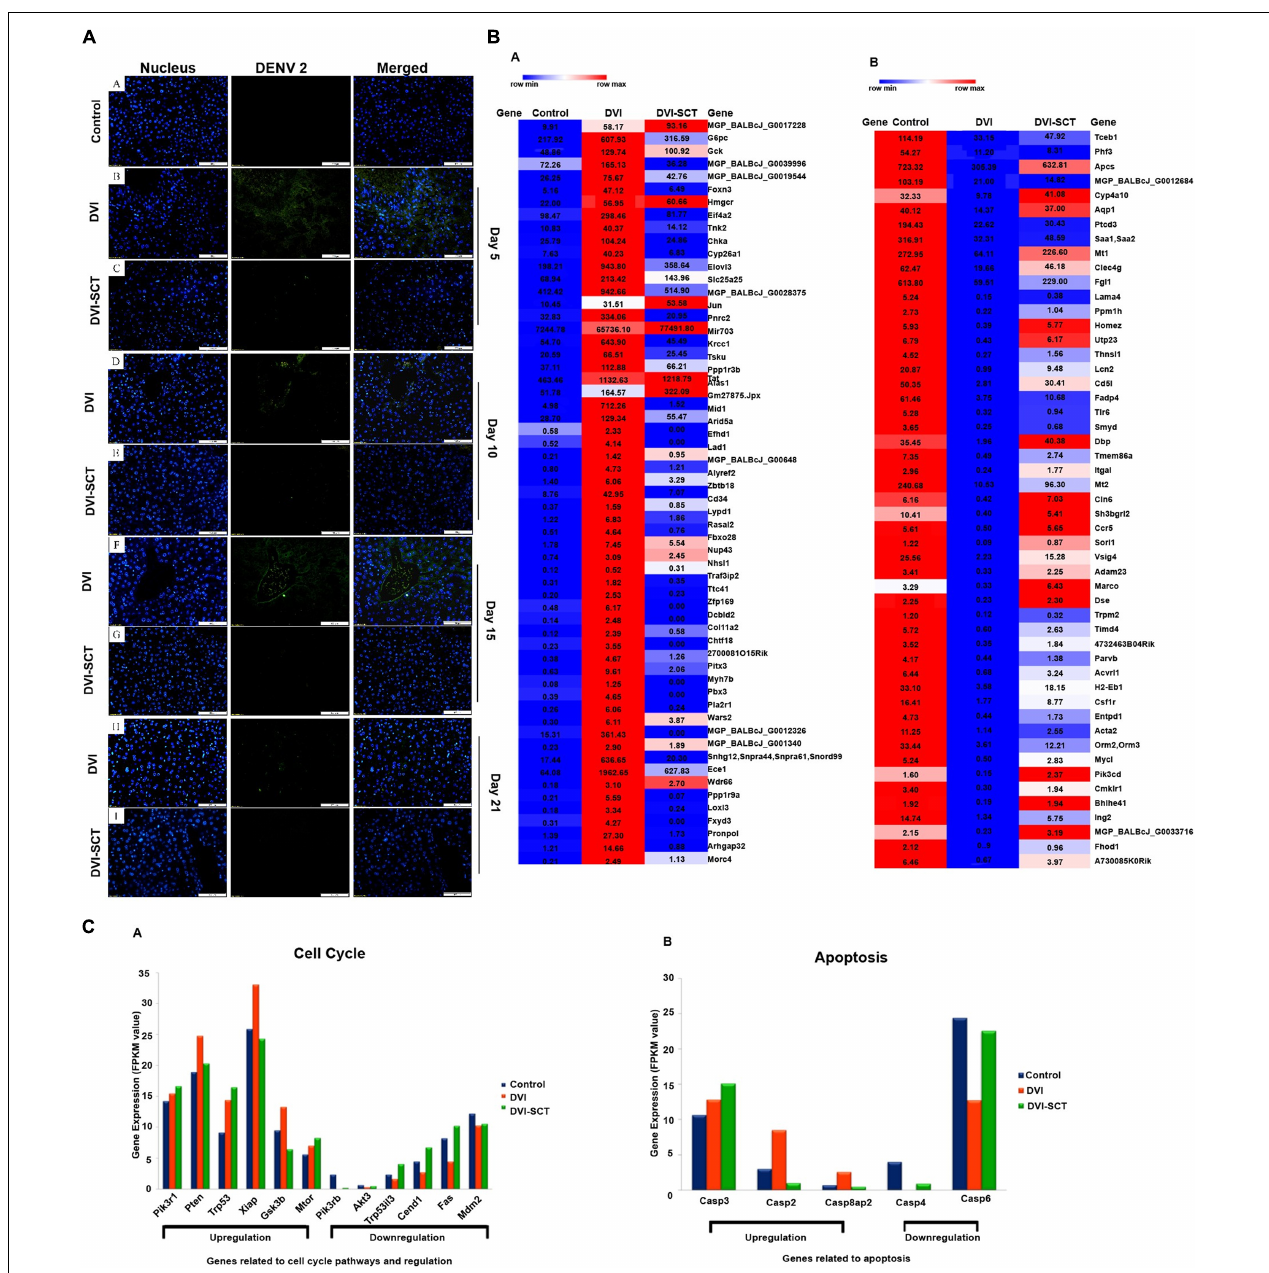
FIGURE 3 | Immunohistochemical assessment and next-generation sequencing. (A) Immunohistochemical study of DENV-infected BALB/c mice liver at different dpi. Liver sections were captured at a magnification of × 200 under a fluorescence microscope. (a) Control group, (b,c) liver sections of DENV-infected and stem-cells-treated mice on the 5th dpi, (d,e) 10th dpi, (f,g) 15th dpi, and (h,i) 21st dpi. Blue (DAPI-stained nuclei) and green (Alexa Fluor stained DENV antigen). The green fluorescence seen in the DVI group was diminished in the DVI-SCT group. (B) Heatmap of upregulated genes. (C) Heatmap of downregulated genes. The dysregulation (up - or downregulation) of liver genes was quantified in three sets of BALB/c mice: control mice injected with Eagle’s minimum essential medium (EMEM) and phosphate-buffered saline (PBS); DVI mice infected with DENV2; and DVI-SCT mice infected with DENV2 and treated with HSCs, EPCs, and growth factor ( n = 3). The heat maps generated were quantified based on the row minimum and row maximum values (specific for each gene), with red indicating genes highly upregulated and blue depicting genes downregulated. (a) Gene expression related to cell cycle pathways and regulation. The genes Pik3r1 , Pten , Trp53 , Xiap , Gsk3b , and Mtor showed gene expression upregulation following dengue virus infection (DVI), which were either corrected to reflect the control levels ( Pten , Xiap , and Gsk3b ) or continuously upregulated to benefit mice ( Pik3r1 , Trp53 , and Mtor ) upon stem cell treatment (DVI-SCT). Meanwhile, the genes Pik3r6 , Akt3 , Trp53i13 , Ccnd1 , Fas , and Mdm2 showed downregulation upon dengue virus infection (DVI), which was also all corrected to reflect control values upon stem cell treatment (DVI-SCT). (b) Upregulated and downregulated genes related to apoptosis. The genes Casp3 , Casp2 , and Casp8ap2 showed upregulated gene expression following dengue virus infection (DVI) and was corrected to reflect control levels ( Casp2 and Casp8ap2 ) or continuously upregulated to benefit mice ( Casp3 ) upon stem cell treatment (DVI-SCT). Meanwhile, the genes Casp4 and Casp6 showed downregulation upon dengue virus infection (DVI), which was corrected to reflect control levels upon stem cell treatment